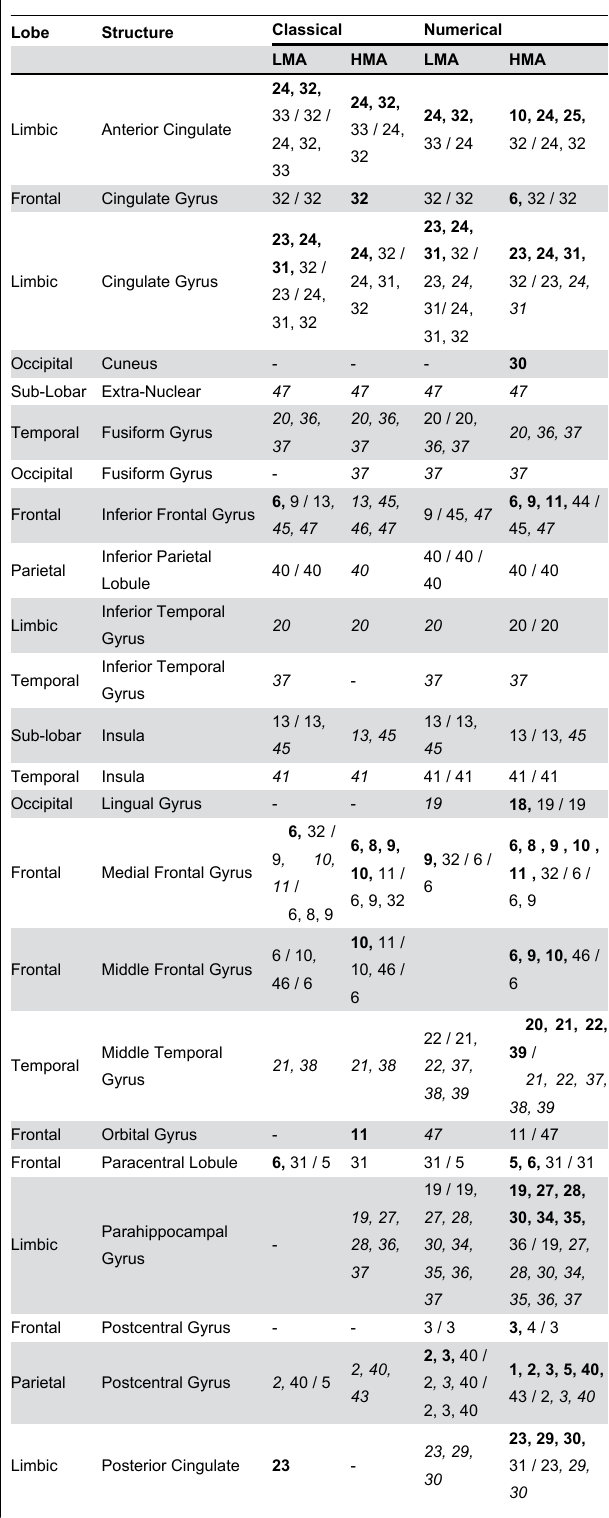
Table 3. Pearson correlation coefficients ( p values under brackets) between the sMARS scores and ERN, CRN and ERN-CRN components (at Fz) and Pe component (at Cz) amplitudes for the numerical and the classical Stroop tasks for the whole sample (n=34).